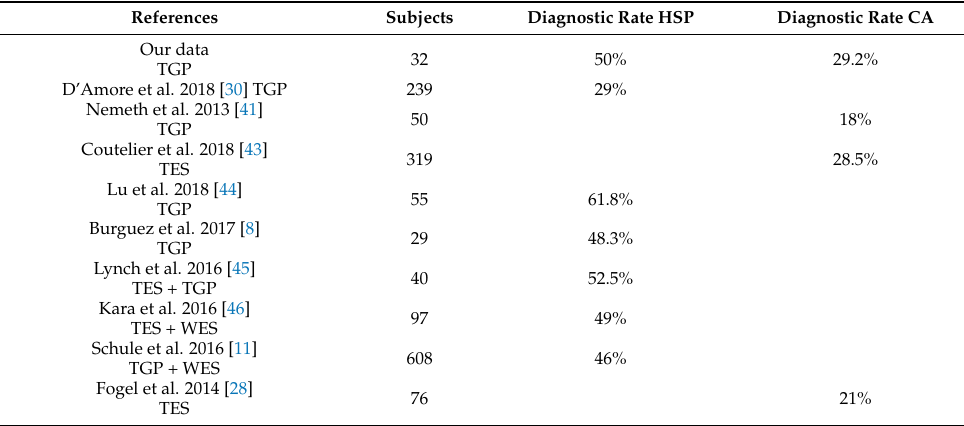
Table 3. Diagnostic yield comparison between results of this study and recent literature works on HSP and CA cohorts through NGS techniques. References numbers are in brackets. Abbrevations: HSP, Hereditary Spastic Paraplegia; CA, Cerebellar Ataxias; TGP, Targeted resequencing panels; TES, Targeted exome sequencing; WES, whole-exome